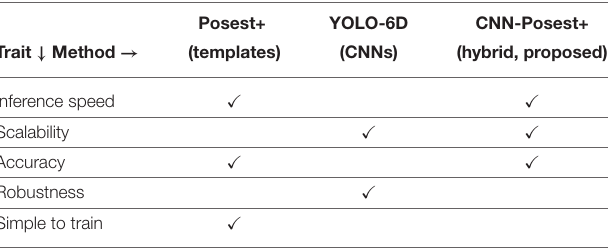
TABLE 1 | The three evaluated methods for 6D object pose estimation from RGB input and their experimentally determined traits. Posest+ YOLO-6D